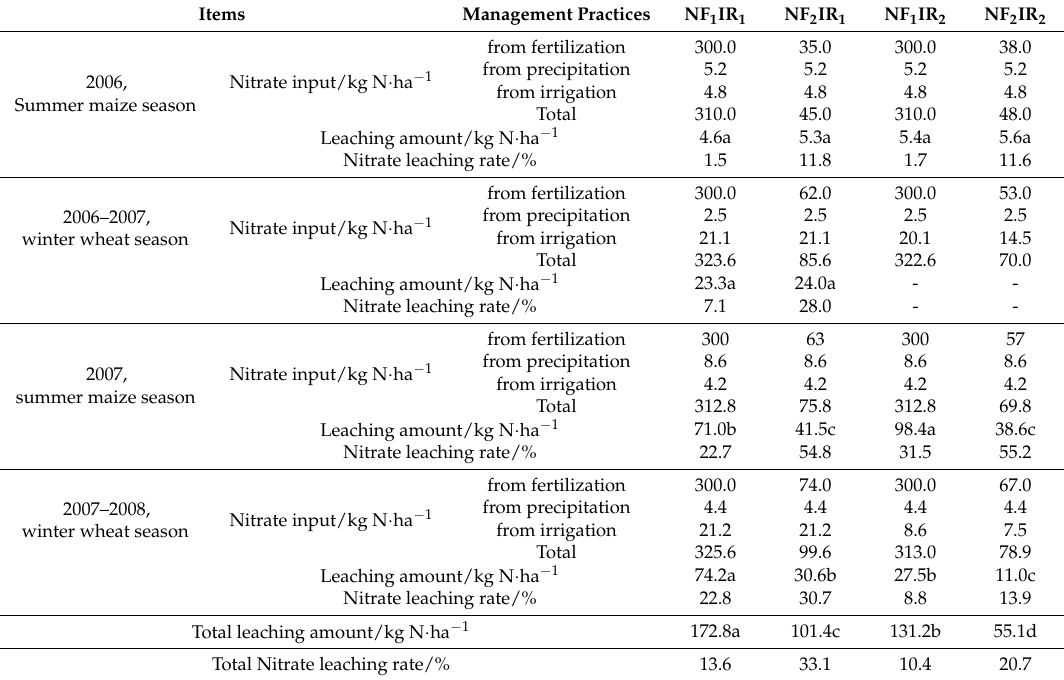
Table 3. Summary of nitrate inputs from rainfall, irrigation water and N fertilizer applied, and nitrate leaching in both wheat–maize cropping